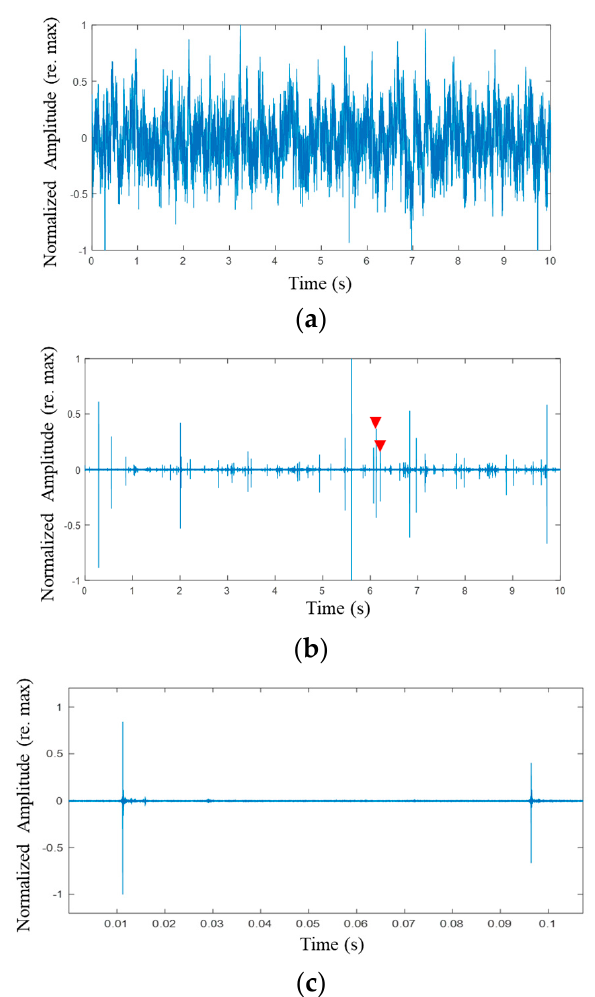
Figure A1. ( a ) Raw acoustic signal data measured from the hydrophone along with 10 s long time ( b ) Band-pass filtered acoustic data used for finding the TVC events, and two TVC events are selected for the localization ( c ) Selected 0.1 s long snapshot involving the adjacent pop-type cavitations.